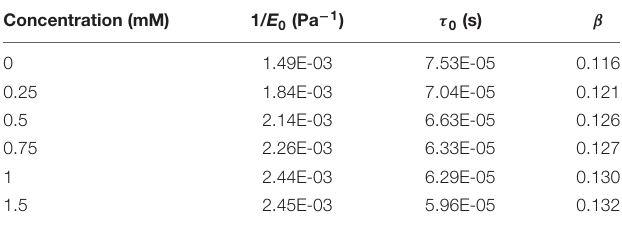
TABLE 1 | Least-square fitting parameters for the power-law